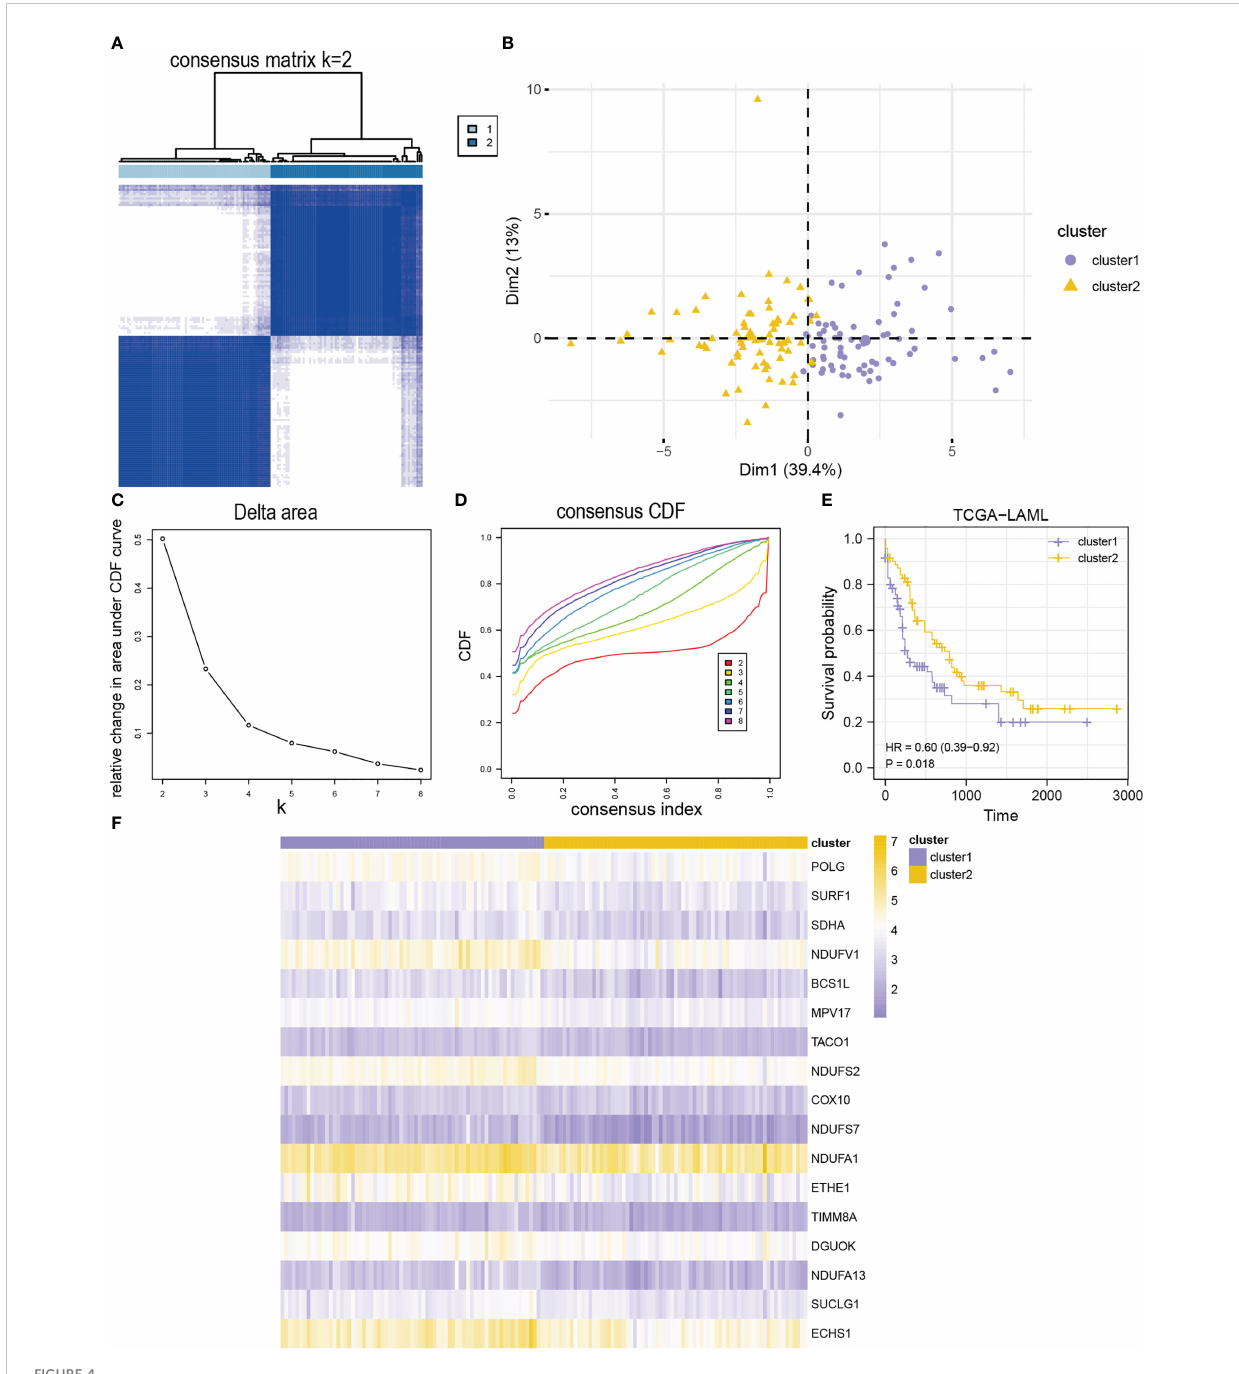
FIGURE 4 Identi fi cation of AML subtypes based on 17 module MMRGs. (A) The consensus clustering matrix of the TCGA-LAML cohort for K = 2. (B) Principal component analysis for the expression pro fi les of two AML clusters in the TCGA-LAML dataset. (C, D) . Relative changes in the area under cumulative distribution function (CDF) curve (C) , and consensus clustering CDF for k = 2-8 (D) . (E) KM curves of two AML clusters in the TCGA-LAML cohort. (F) Heatmap of 17 module MMRGs in the two AML